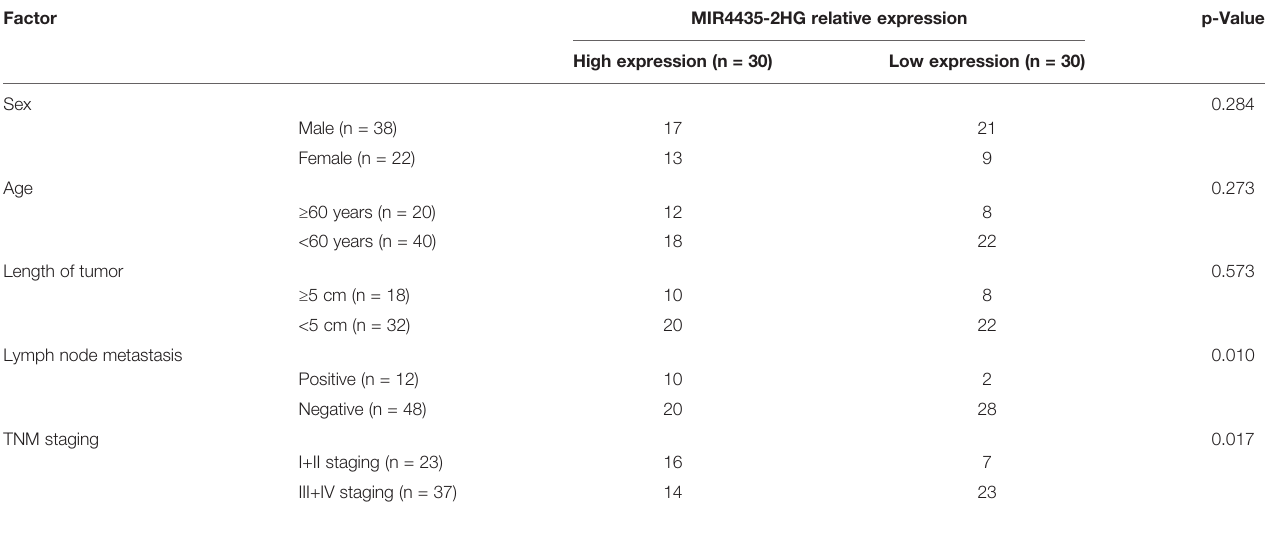
TABLE 2 | The relationship between MIR4435-2HG and clinical data of gastric cancer patients.